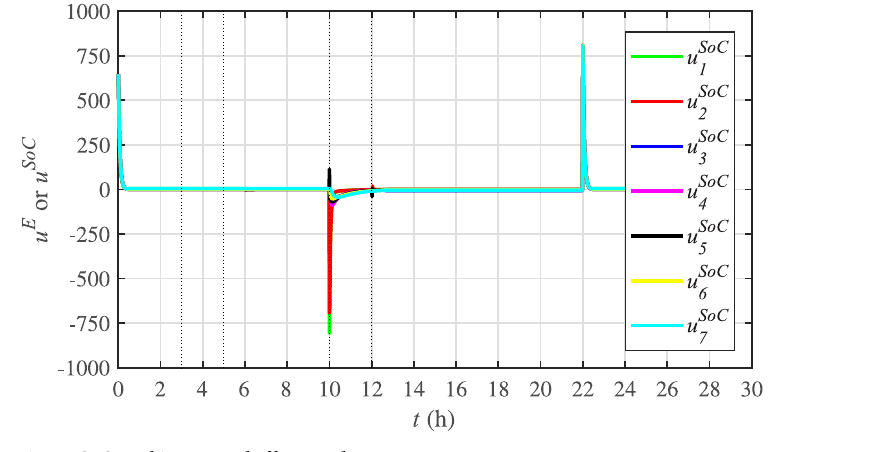
Fig 23. SoC tracking control efforts under case 2.